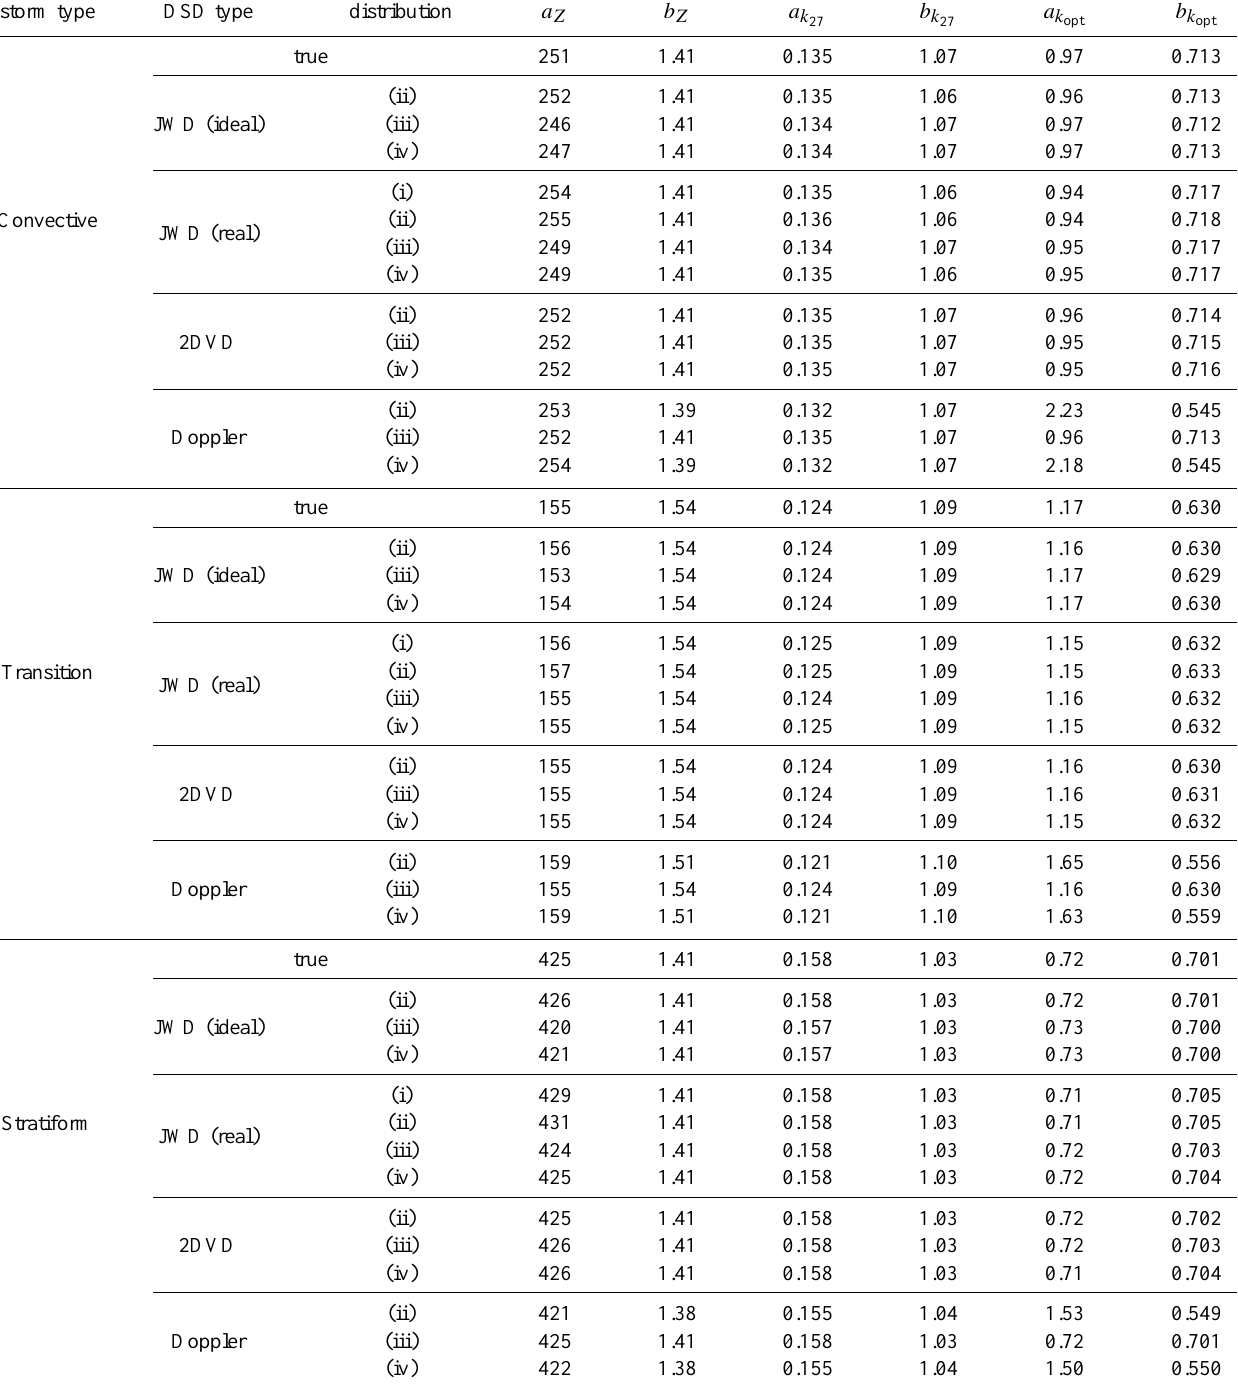
Table 3. Coefficients a and exponents b of fitted Z − R , k 27 − R , and k opt − R relations for different simulated DSDs (see Table 1 for the meaning of (i)–(iv)). Fits were carried out by linear regression of log (Z) , log (k 27 ) , and log (k opt ) on log (R)